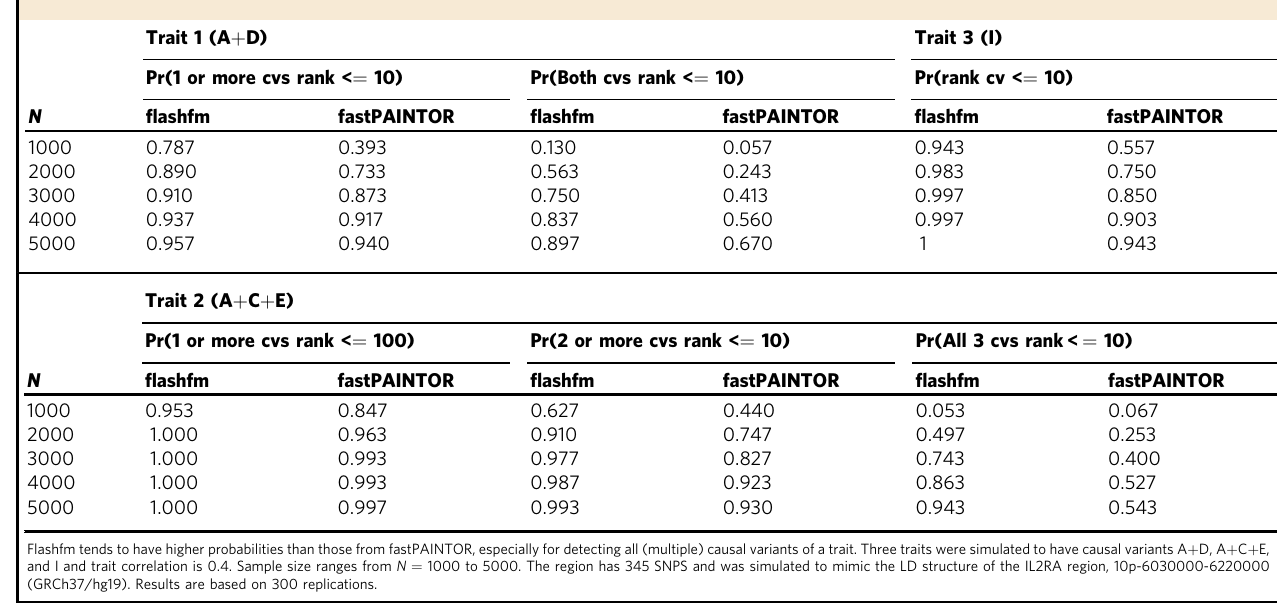
Table 4 Comparison of probabilities that causal variants have rank 10 or less, from fl ashfm and fastPAINTOR, varying sample size.